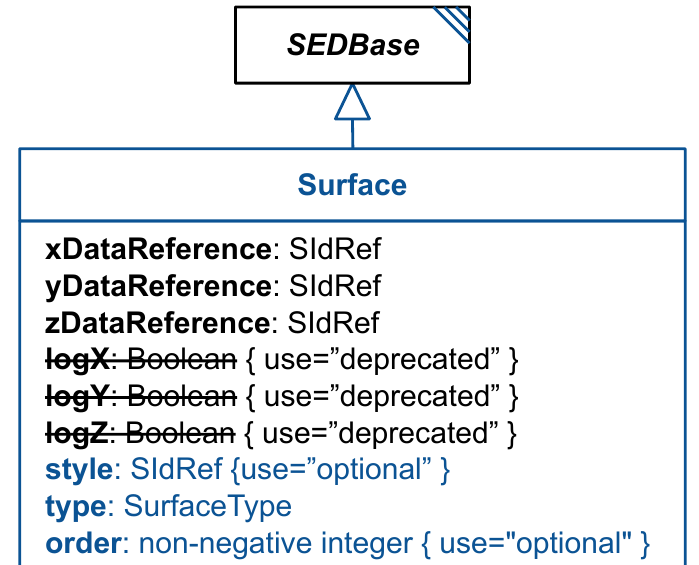
Figure 2.23: The definition of the SED-ML Surface